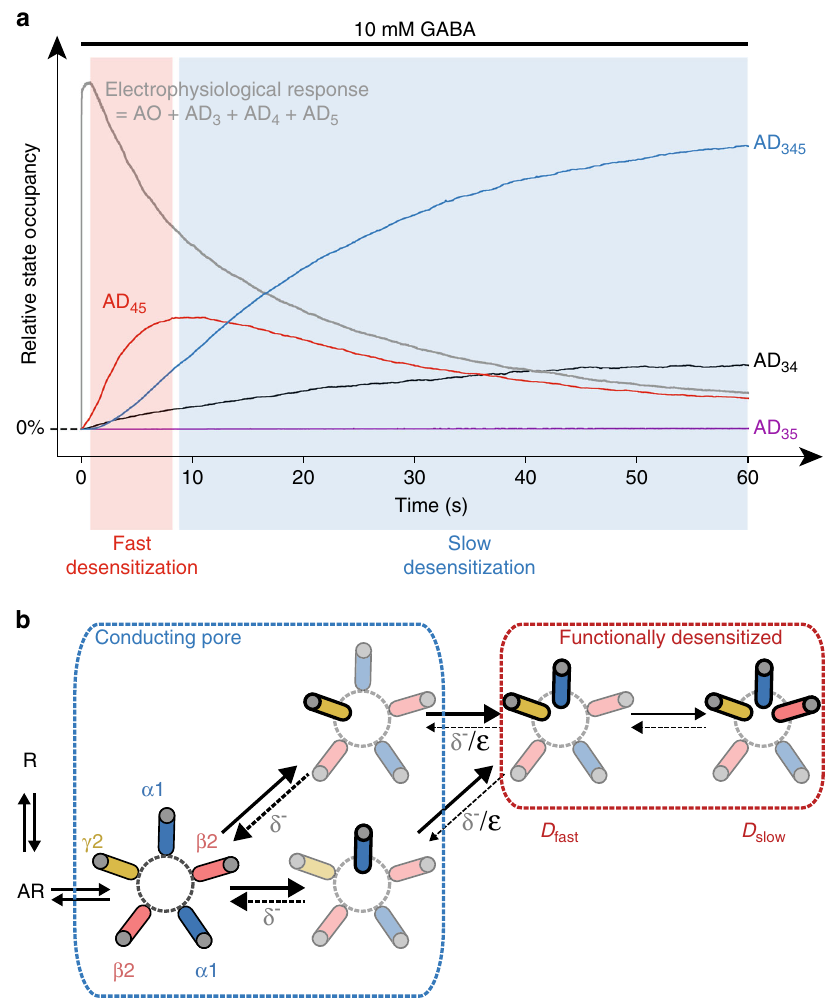
Fig. 8 States occupancies predictions and structural depiction of Model III. a The overall population of wild-type receptors in an active conformation is compared to the relative occupancies of the various desensitized states. As depicted by the red box, the early phase of desensitization is carried by the AD 45 state. On longer timescales (blue box), slow desensitization is largely embodied by the entry in the AD 345 state. The analysis of states occupancies was performed with QuB simulations. b In this simpli fi ed depiction of model III, we extracted the kinetically favored pathway for the desensitization of wild- type α 1 β 2 γ 2 GABA A Rs. Upon agonist binding, the receptor is transiently stabilized in a fully open pseudo-symmetrical conformation. The two fi rst subunits to rearrange during desensitization are the α 1 and the γ 2 subunits involved in the binding of benzodiazepines, namely SU4 and SU5 in our concatemers. While one desensitized subunit is not enough to occlude the pore, fast desensitization corresponds to the rearrangement of both SU4 and SU5 subunits, which are coupled. Slow desensitization is then driven by the slower rearrangement of the SU3 subunit, i.e. the β 2 subunit opposite to the γ 2